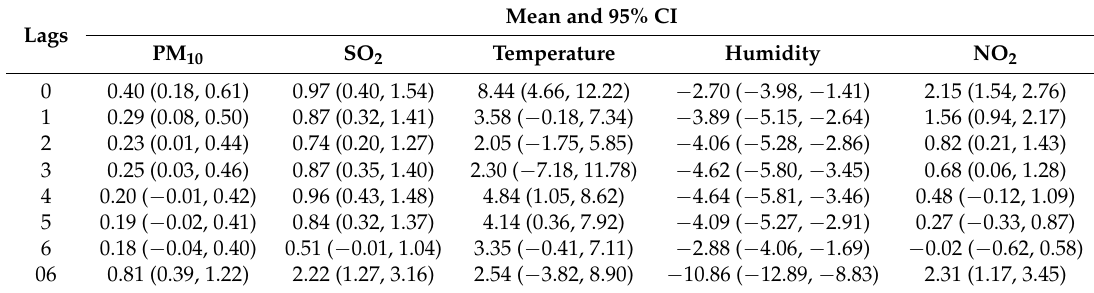
Table 2. Percent change (mean and 95% confidence intervals) in daily outpatient visits for eczema associated with 10 unit change of environmental variables using different lag days.